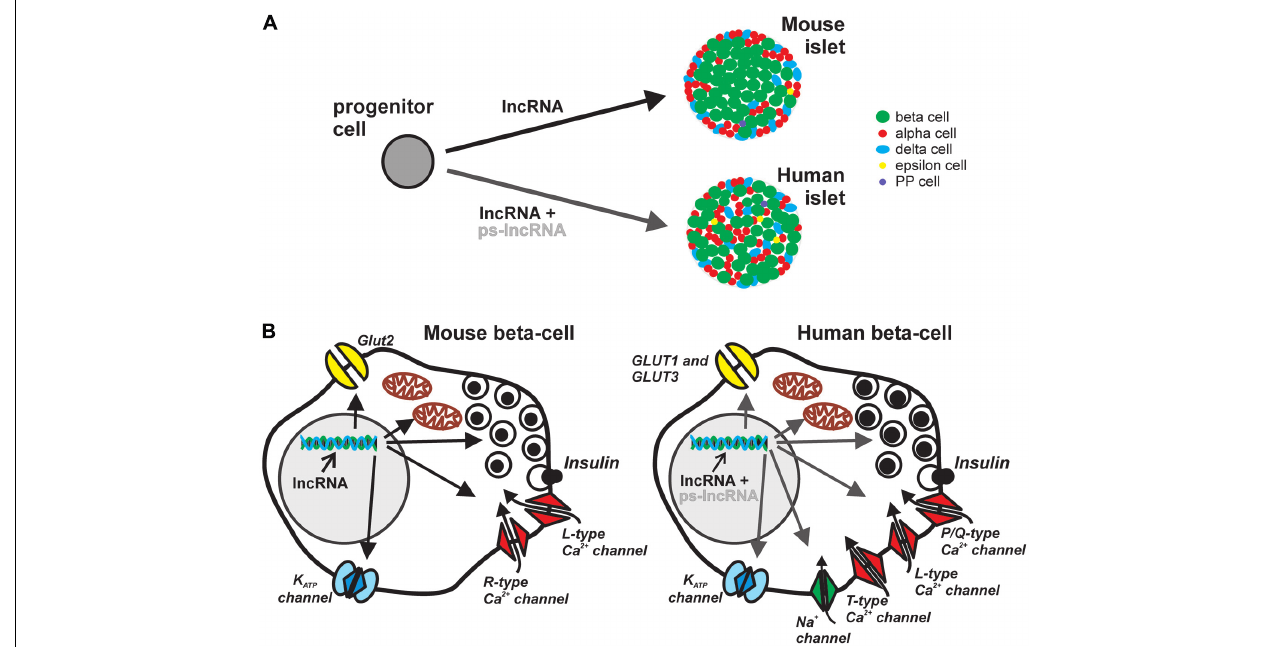
cluster of primate-specific (ps)-lncRNAs discovered in human cells. (B) The role of lncRNAs in endocrine islet cell functions, here represented by the components of canonical stimulus-secretion coupling in mouse (left) and human (right) beta cells, may also be in the level of transcriptional and epigenetic regulation of factors involved in cell-type specific functions. Considerable differences in nutrient sensing, metabolism, exocytotic events and electrophysiological properties between human and mouse beta cells may be a consequence of differential regulation of relevant genes, e.g., ion-channels and exocytotic proteins, by